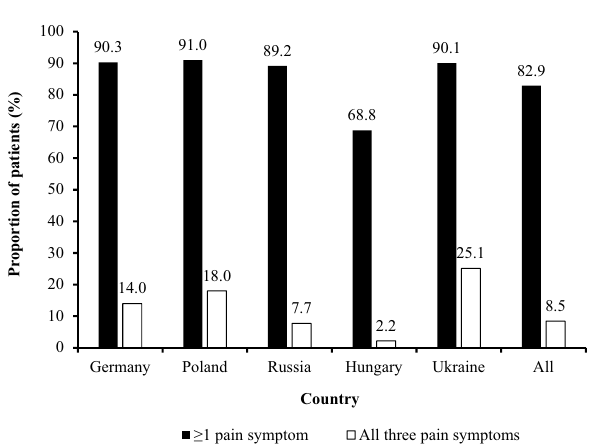
Figure 2. Patients reporting at least one of three selected pain symptoms (pelvic pain, pain during/after intercourse, and painful periods) and all three symptoms, by country. Patients from Switzerland are not presented here as a subcategory owing to low patient numbers ( n =